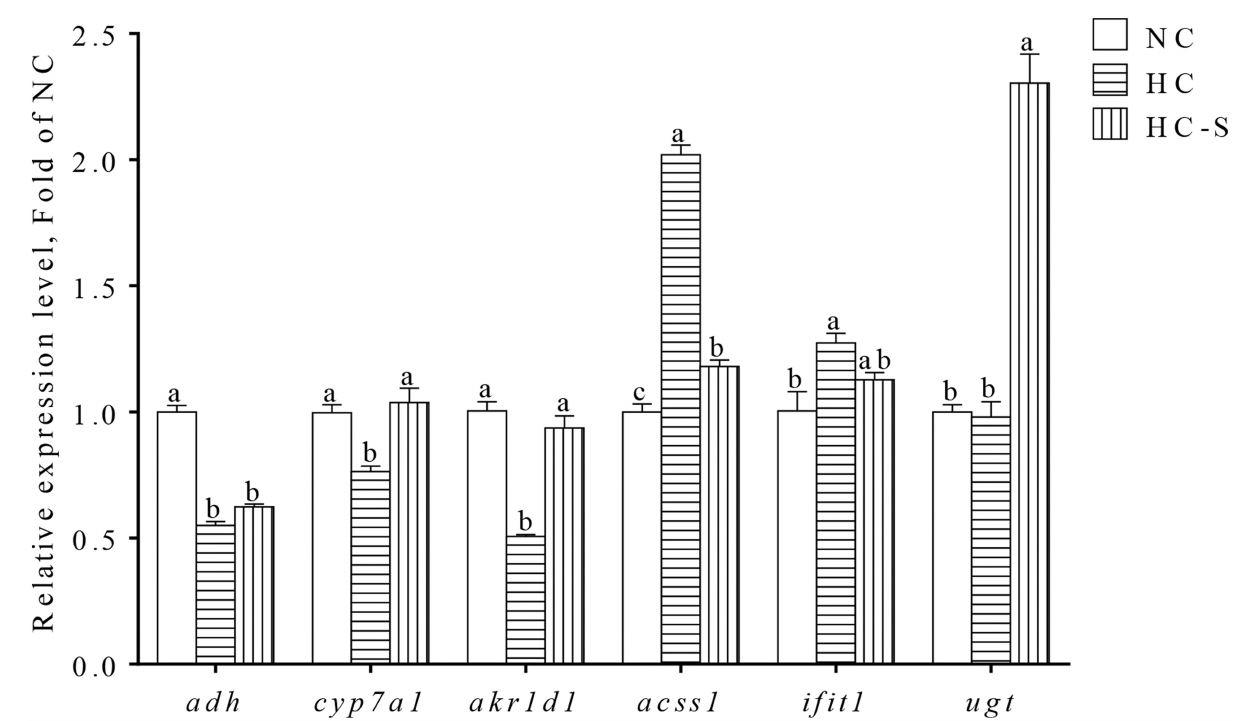
FIGURE 3 | Quantitative real-time PCR (qPCR) analysis of hepatic DEGs in swamp eel fed HC diet. Values are presented as means ± SEM, n = 16 fish/diet. Columns with different superscripts indicated values with significant difference, p < 0.05 was significantly different.